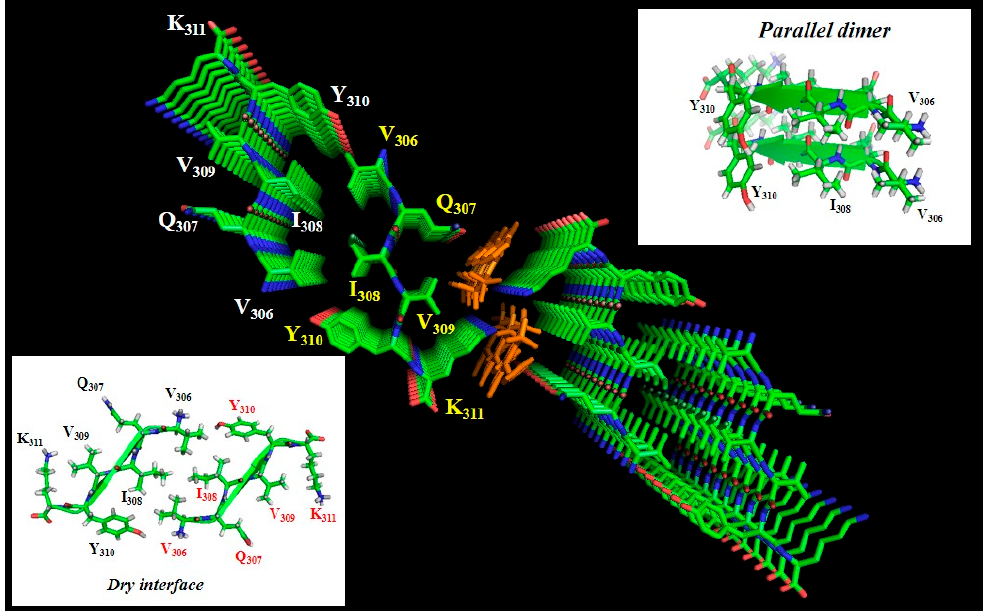
Figure 3. Crystal structure of the PHF6 peptide in complex with orange G (PDB code 3OVL), seen along the fiber axis from the top. Inserts show the antiparallel dry interface between opposing peptides, or the parallel stacking between adjacent peptides in the same plane. Orange G has two sulfate groups separated by 5 Å, and thereby compensates the lysine side ‐ chain positive charges of two adjacent peptides [120].